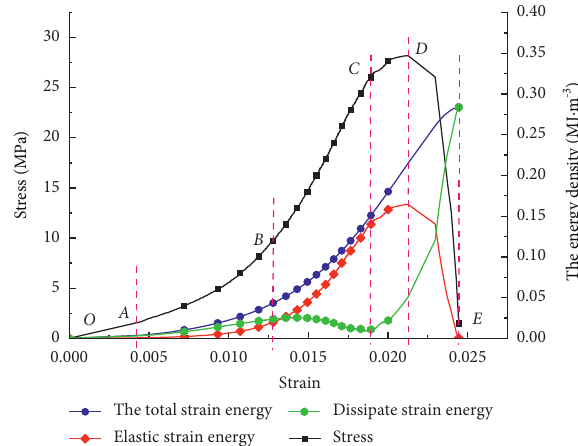
Figure 6: Energy density curves of typical natural rock samples.